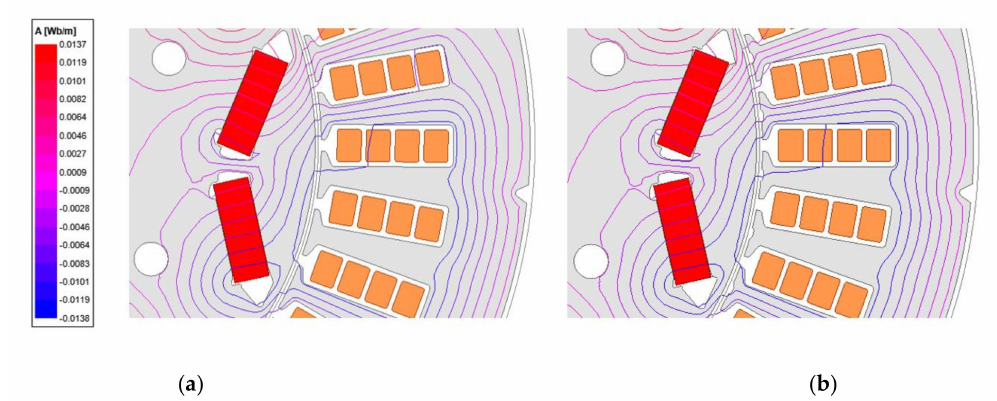
Figure 9. Flux distribution at the load operation: ( a ) Initial model; ( b ) Optimal model.